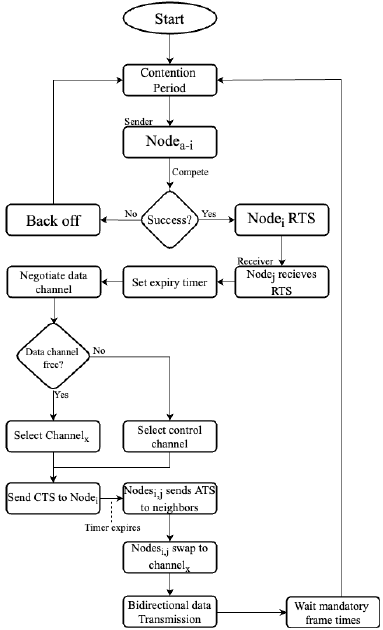
Figure 2. Flow diagram of the proposed E-SA-MMAC